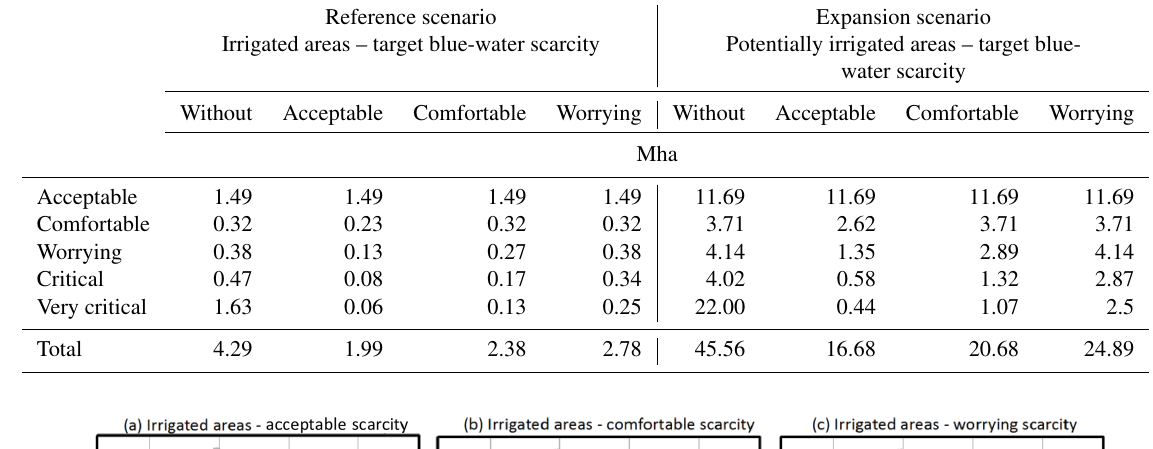
Table 4. Extent of current and potential irrigated areas under various scarcity levels for the reference and expansion scenario.